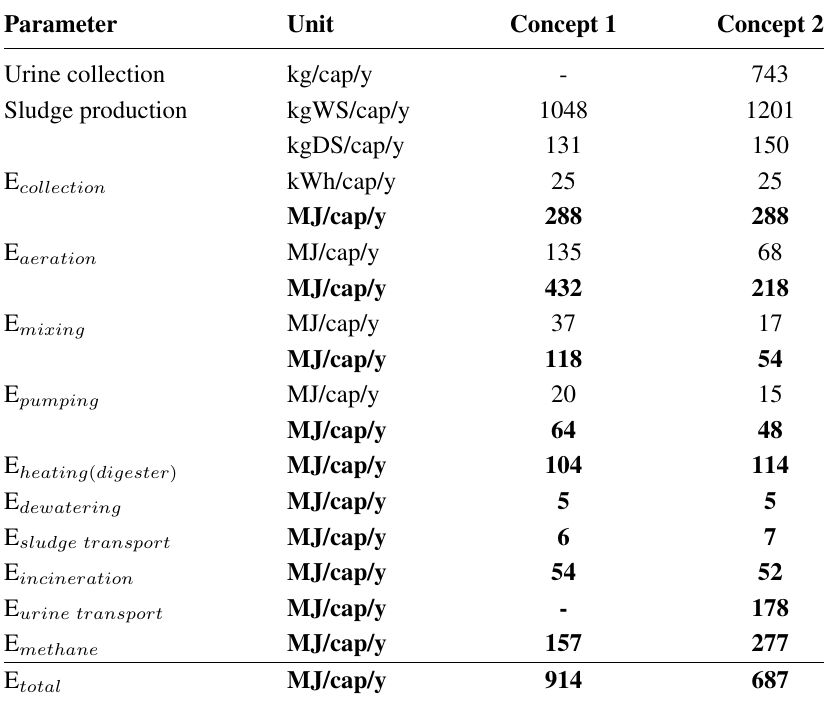
Table A1. Sludge production, urine collection, and energy consumption and production (methane) in Concepts 1 and 2 (primary energy presented as bolded figures).